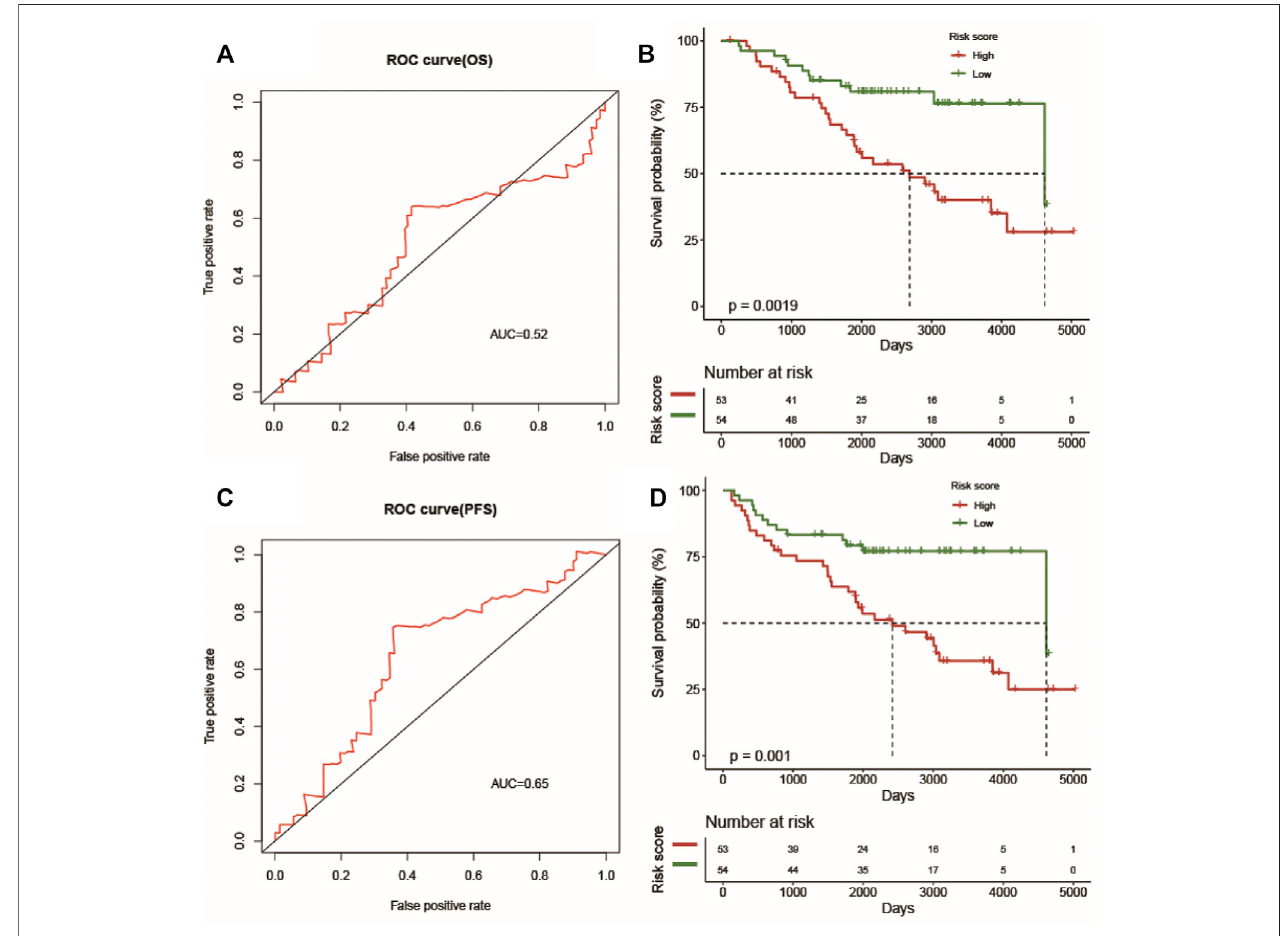
FIGURE8| Theprognosticvalueoftheprognosticindex.TheROCcurveveri fi estheaccuracyofthecombinedmodelinpredictingthe1-yearsurvivalrates (A) and progression-free survival (C) of LUSC patients. Patients in the high-risk group suffered shorter survival rates (B) and progression-free survival (D) .